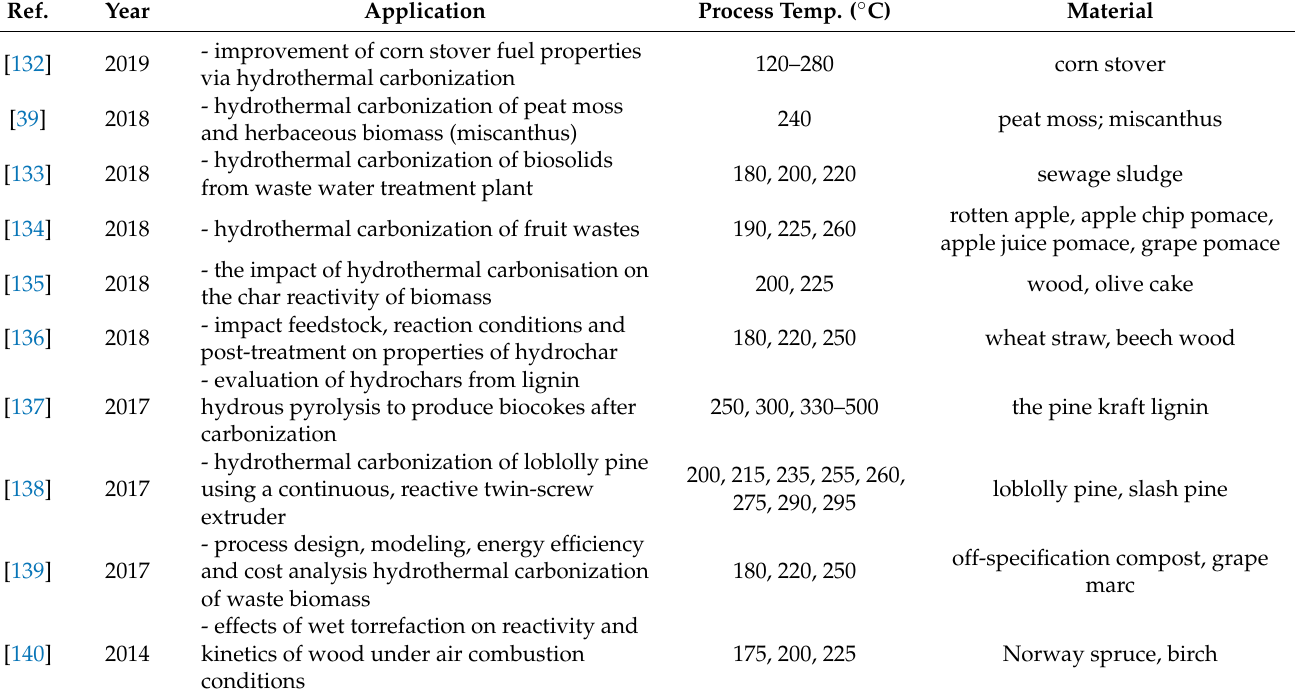
Table A2. Hydrothermal carbonization (HTC)—detailed thematic analysis. Ref.